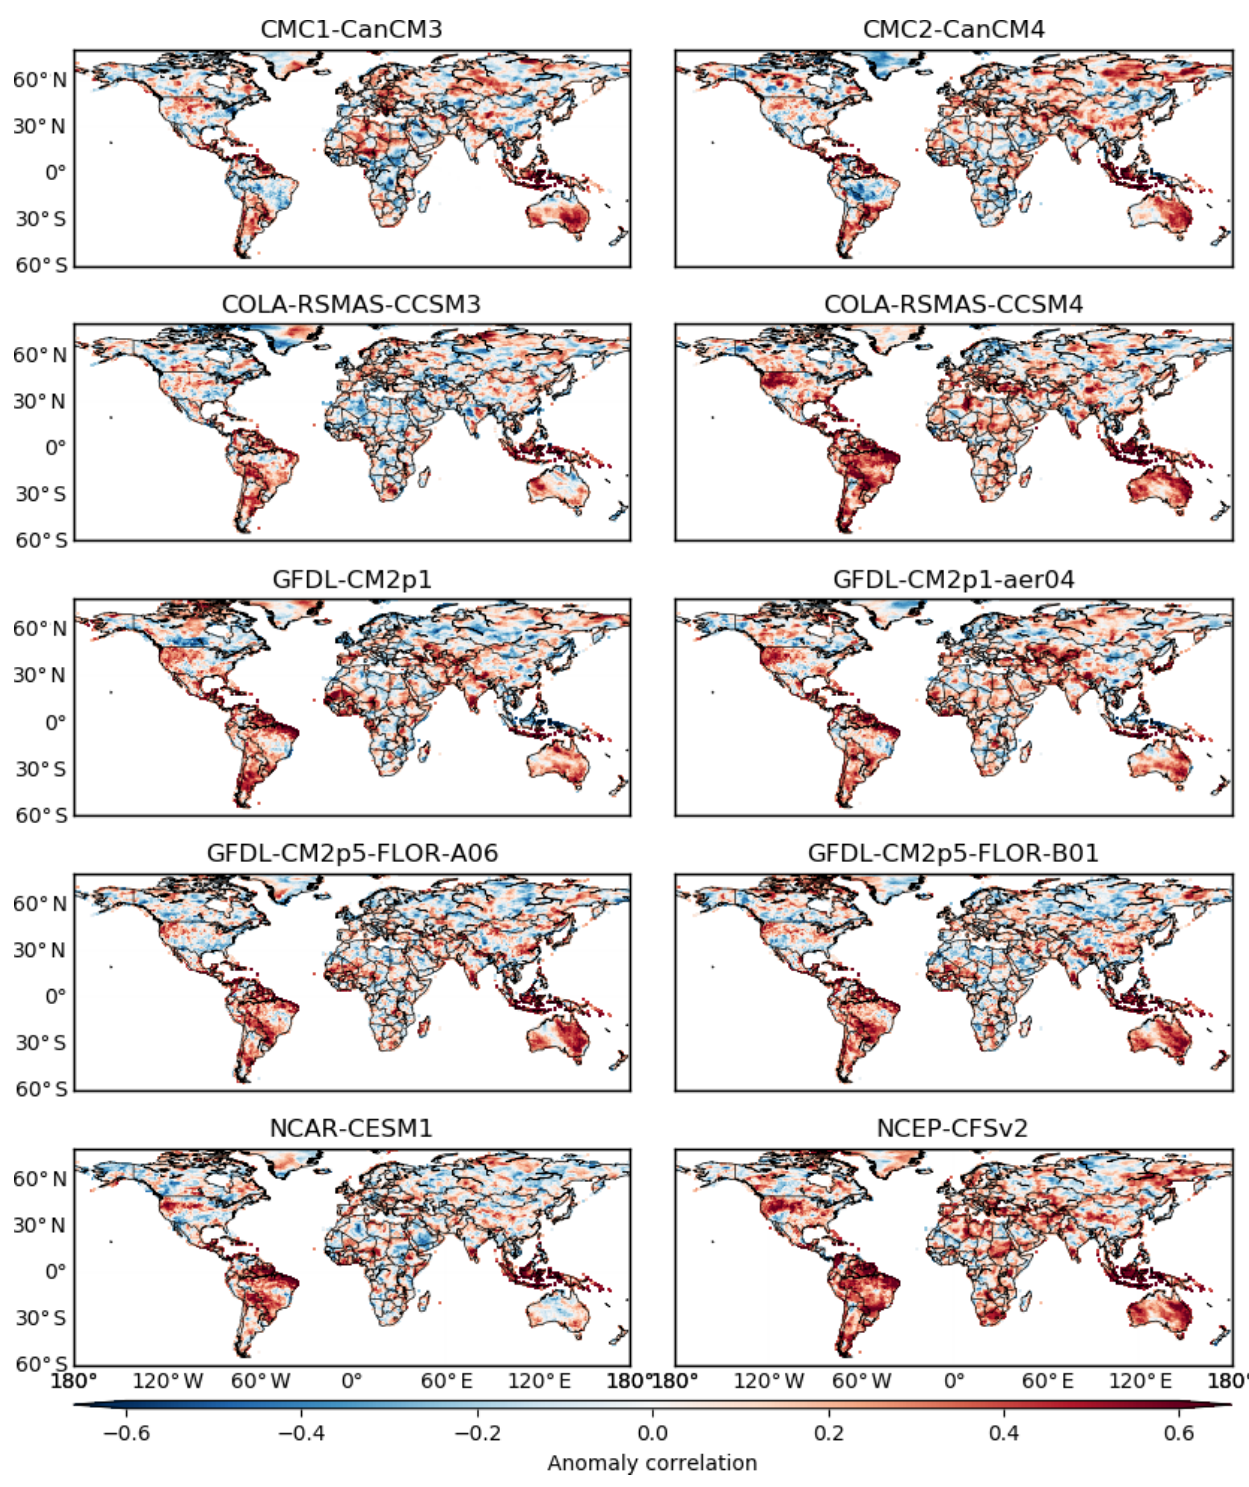
Figure 1. Anomaly correlation between forecast ensemble mean and observation for 10 sets of GCM forecasts of seasonal precipitation. The forecasts are initialized in June and are for the total precipitation in June, July, and